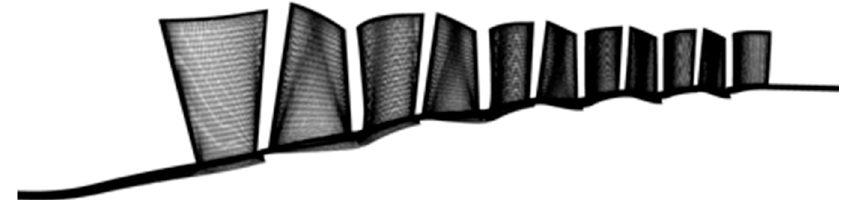
Figure 3. Mesh for the CFD computations.